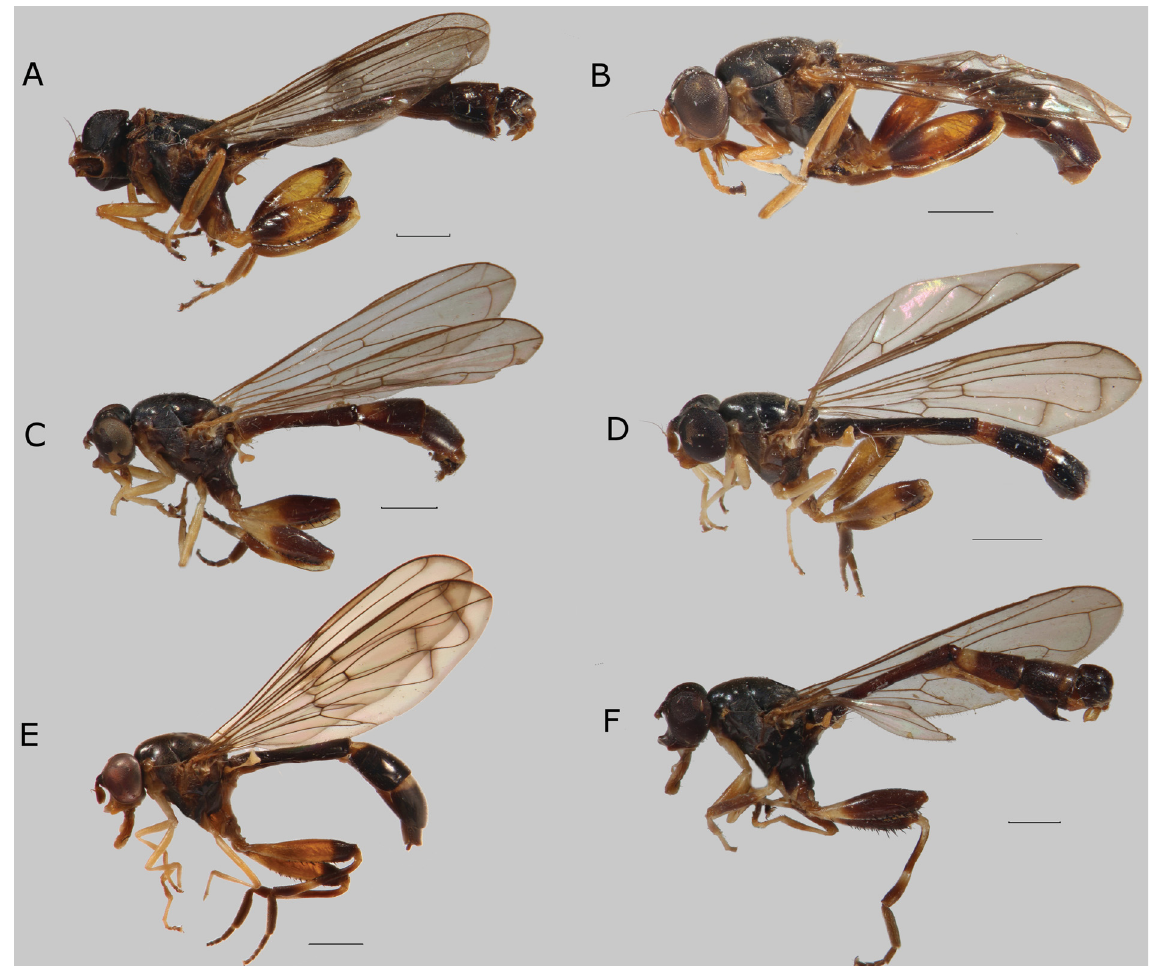
Fig. 86. Habitus, lateral view. A . Sphegina (Asiosphegina) spenceri sp. nov., paratype, ♂ ,